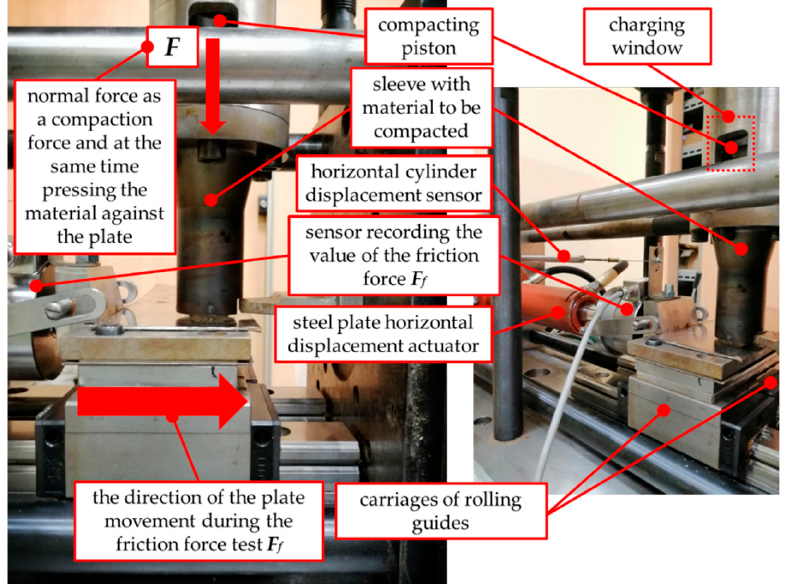
Figure 7. General view of the testing station for the coefficient of friction µ 1 of oak sawdust on a steel plate.